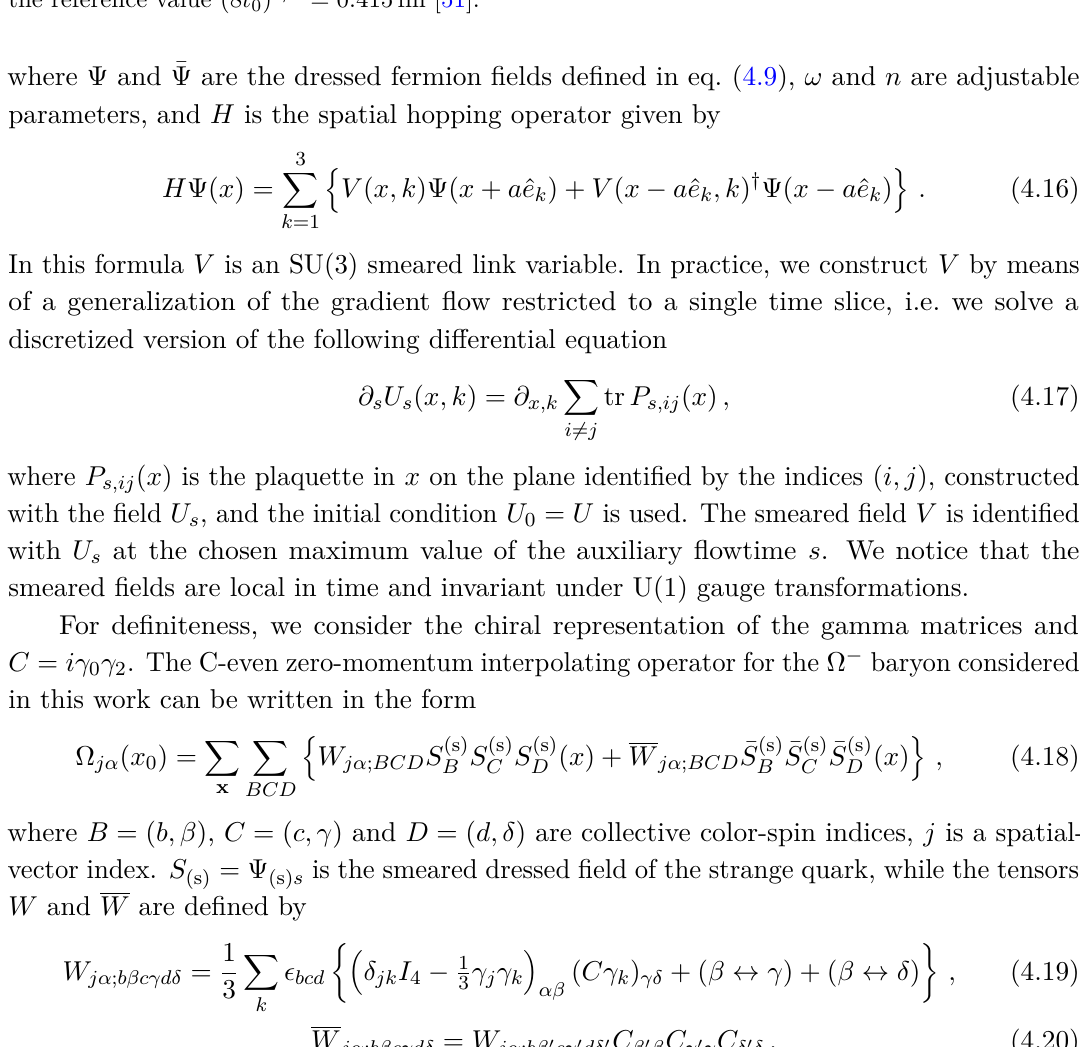
Figure 5 . Meson effective masses and effective φ observables for the ensemble A360a50b324+RW2 , together with the selected plateaux and the fits to a constant. Values in MeV are obtained by using the reference value (8 t 0 ) 1 / 2 = 0 . 415 fm